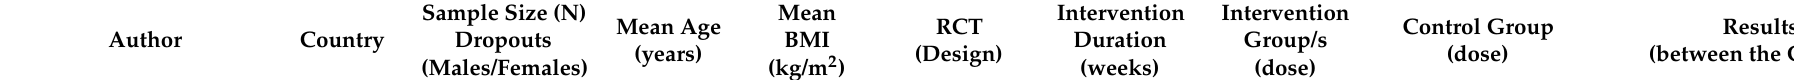
Table 1. Randomized controlled trials (RCTs) included in the